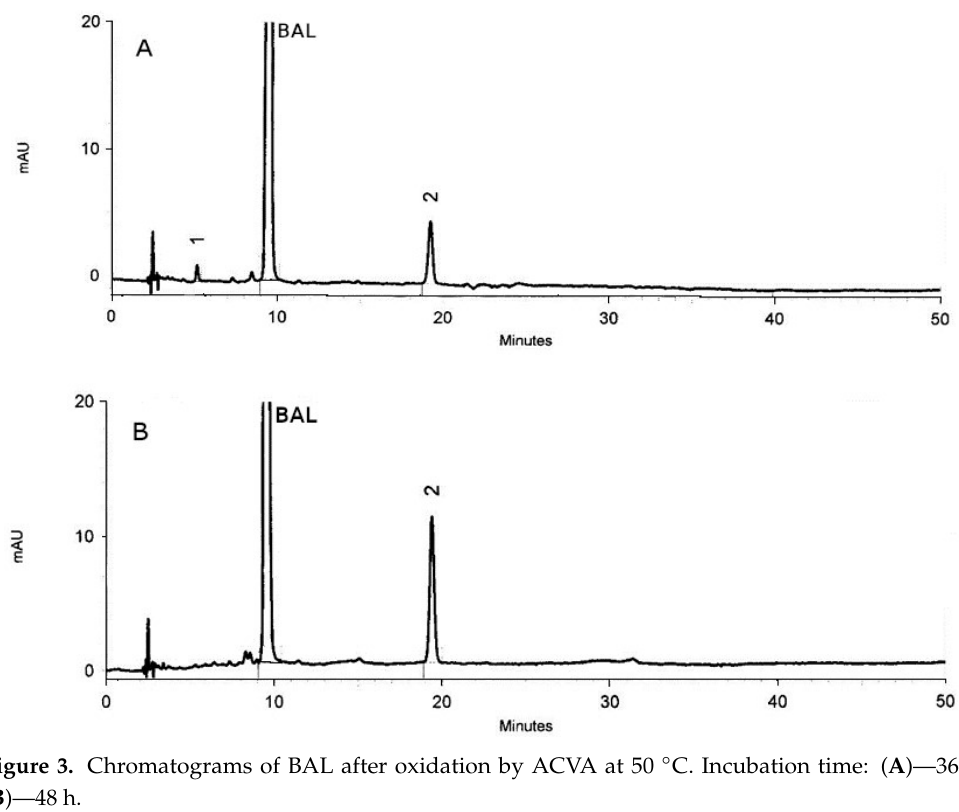
Figure 3. Chromatograms of BAL after oxidation by ACVA at 50 °C. Incubation time: ( A )—36 h, ( B )—48 h.